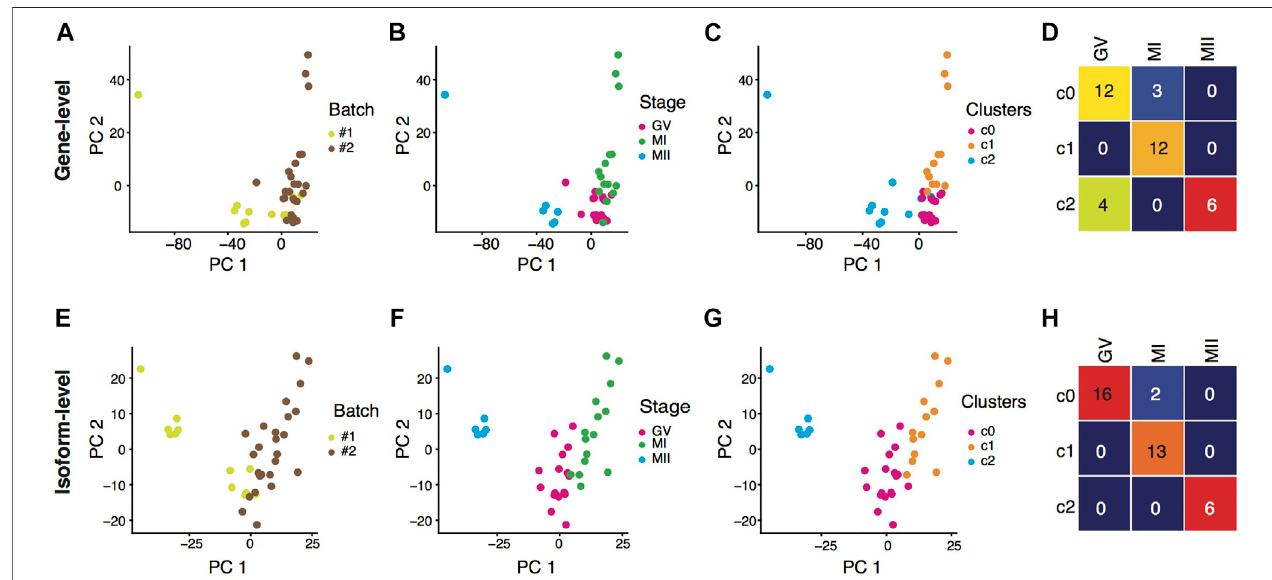
FIGURE1| Isoformexpressionoutperformedgeneexpressioninclusteringoocytes. (A – C) PCAvisualizationofindividualoocytesbasedonbatch-effectcorrected gene-level expression, colored by batches (A) , phenotypic stages (B) , and expression clustering results (C) . (D) Heatmap showing the contingency table between